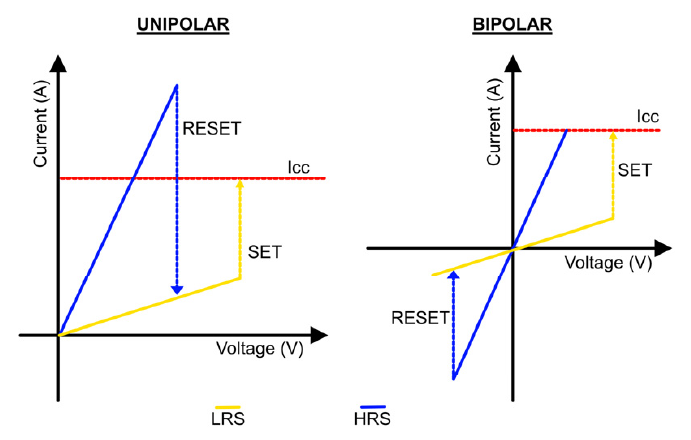
Figure 1. Unipolar and bipolar modes for RRAM devices.